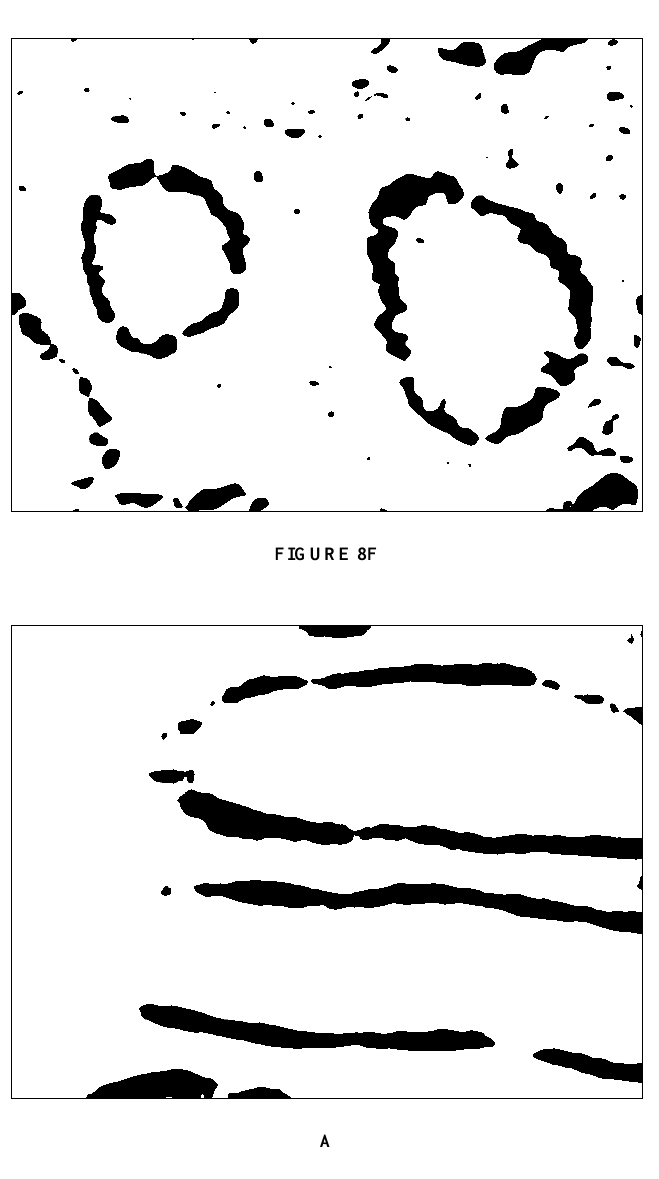
FIGURE 9 . (A–D) The segmented gland regions by the four biased median filters with the same window size in rotations of degrees as described in the